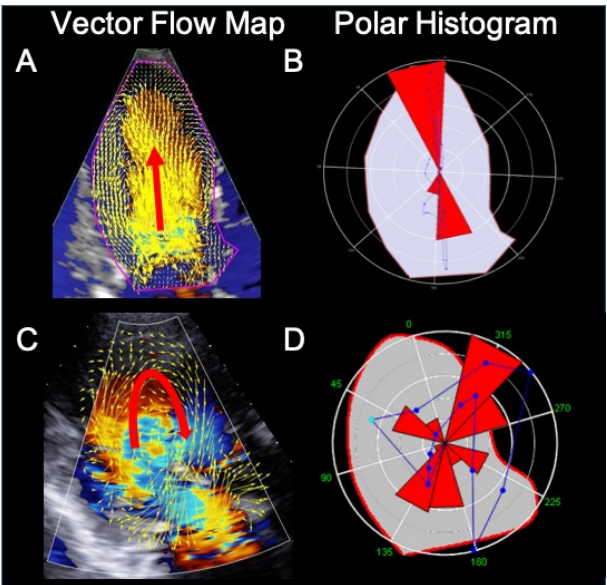
Figure 3. Intracardiac flow analysis of a normal subject ( A ) and ( B ) and a patient with dilated car- diomyopathy ( C ) and ( D ). In the normal subject, during diastole, left ventricular (LV) filling occur mainly along a longitudinal axis (panel ( A ), red arrow). Panel ( B ) shows the intensity-weighted polar histogram representing the distribution and intensity of the LV hemodynamic forces occurring during the entire heartbeat. The hemodynamic forces (in red) are aligned along the LV base–apex direction according with the normal emptying–filling process of the LV. In the cardiomyopathy patient, LV filling is abnormal, with flow circulating along the posterolateral wall and rotating anteriorly at the level of the left ventricular apex (panel ( C ), red arrow). The intensity-weighted polar histogram (panel ( D )) shows a dispersed distribution of the intraventricular hemodynamic forces. Images were obtained using the HyperDoppler software of an Esaote Mylab X8 echo-scanner without contrast